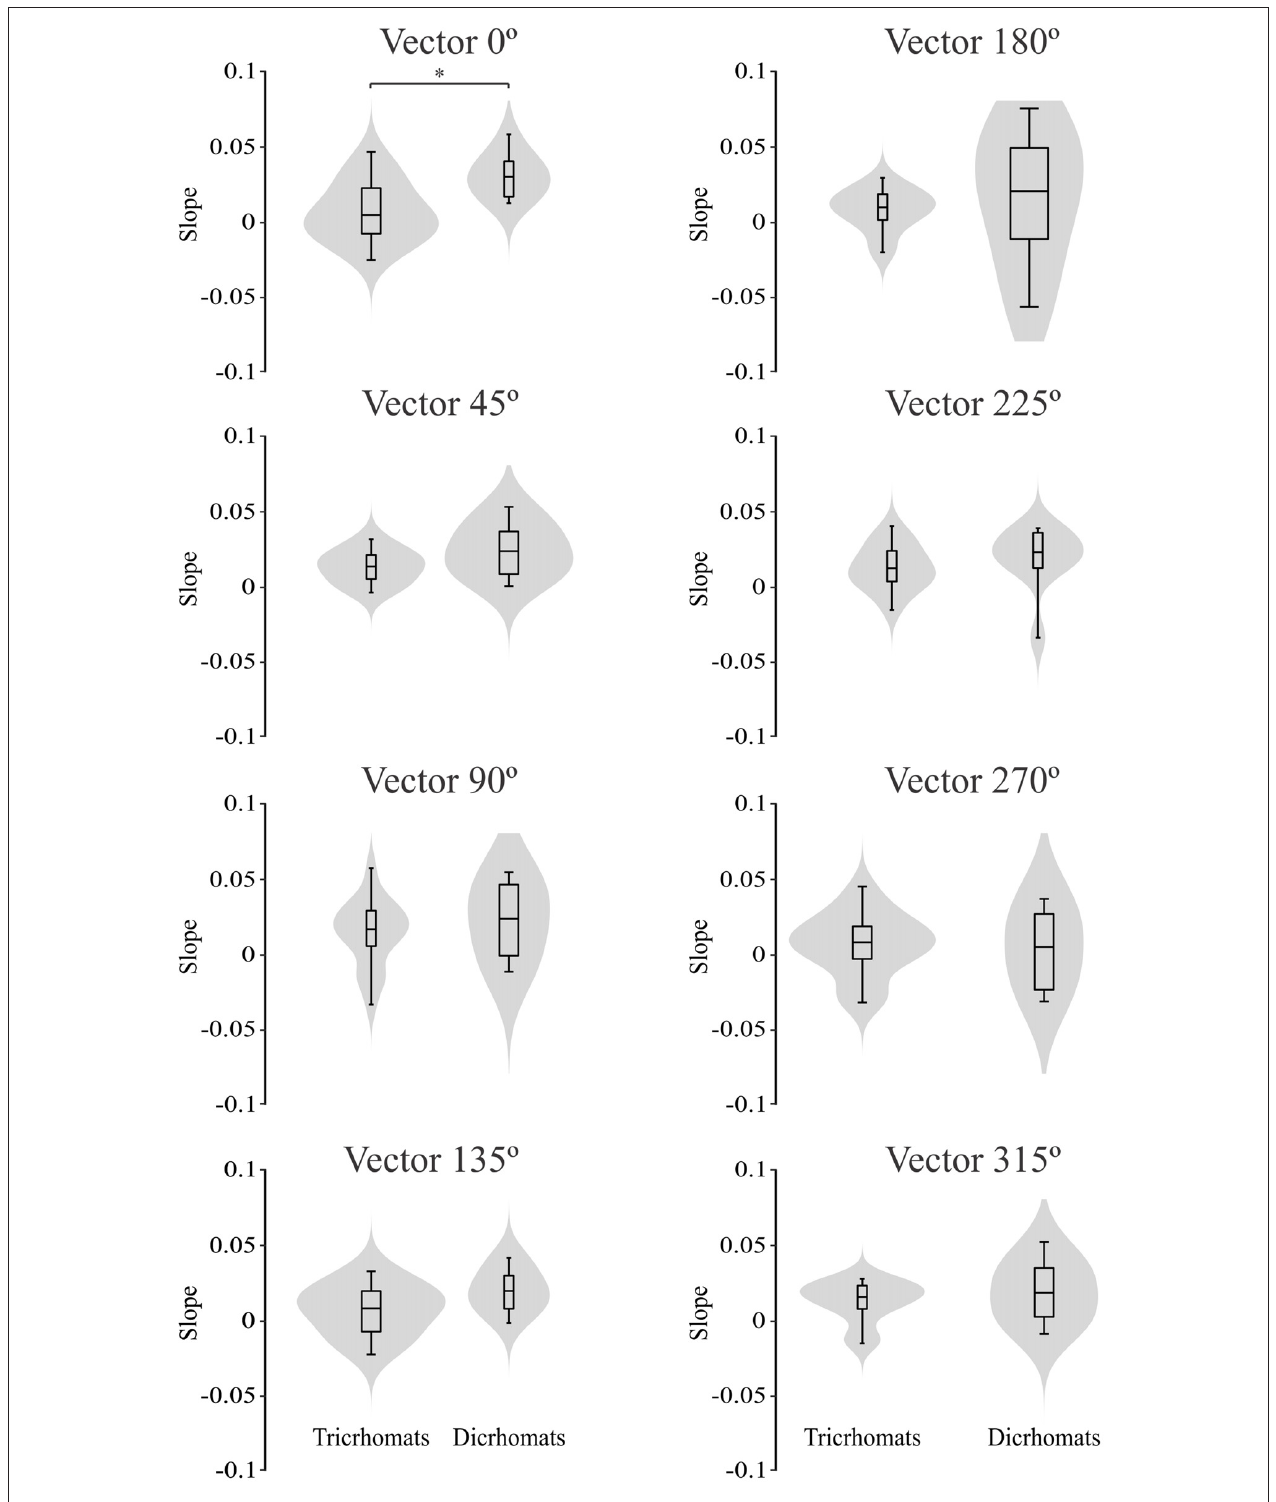
FIGURE 8 | Violin plots comparing the slopes estimated from the best individual linear fits to the chromatic vector thresholds as a function of the luminance noise amplitude from trichromats and congenital dichromats. Only at chromatic vector 0 ◦ , the slopes estimated from functions obtained of dichromats were larger than those obtained from trichromats. Shaded gray areas are the kernel density plot that represents 95% of the data distribution, and the box plot comprises horizontal lines that represent third quartile (upper line), median (middle line), first quartile (lower line) and whiskers represents the maximum and minimum values. ∗ p < 0.05.